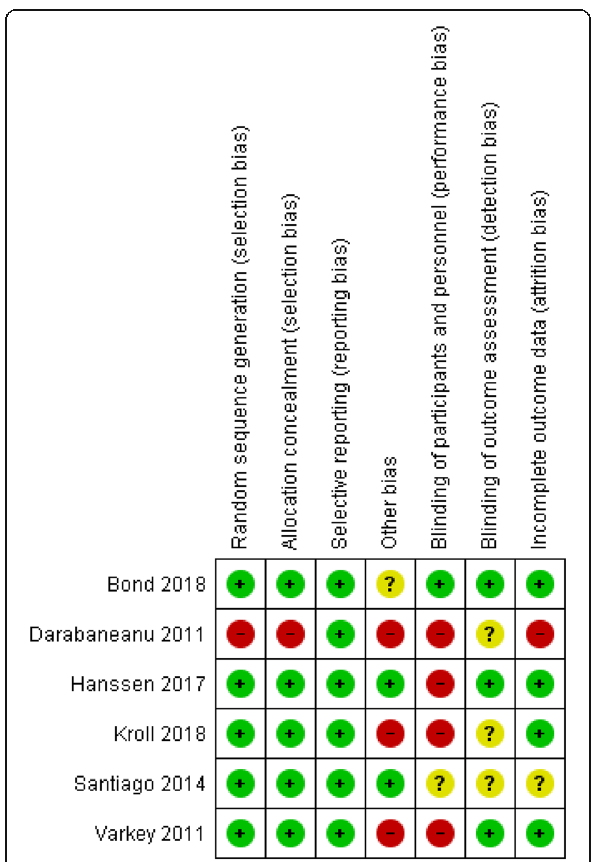
Fig. 1 Risk of bias summary: review authors ’ judgements about each risk of bias item for each included study (Risk of Bias scale)